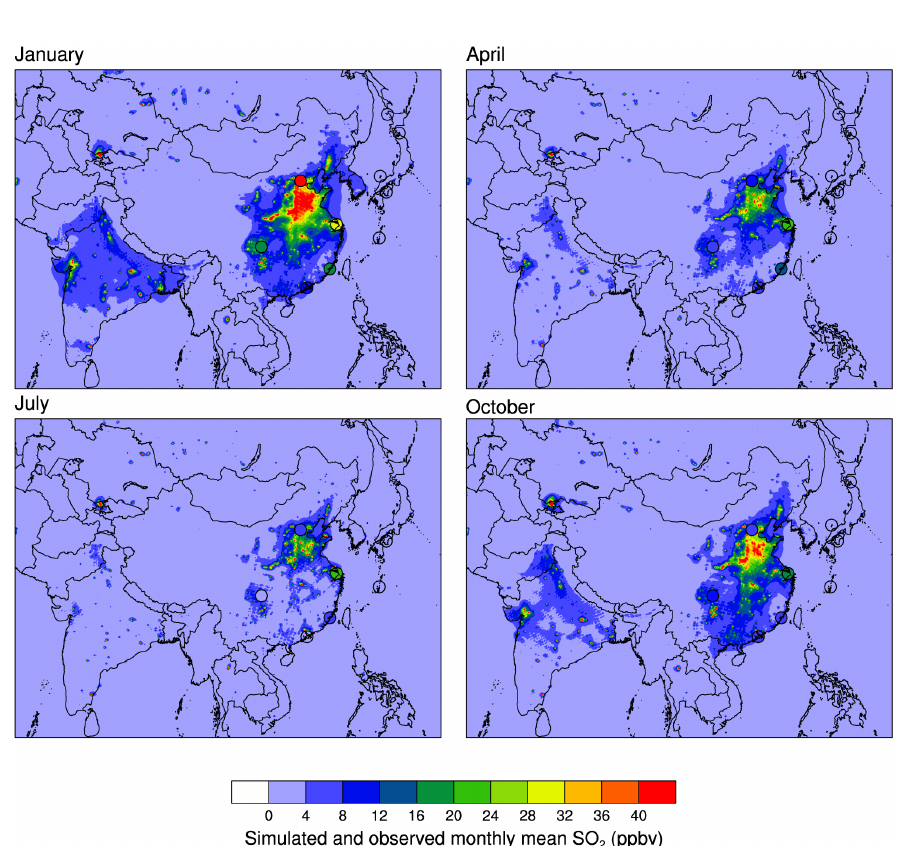
Figure 9. Simulated and observed monthly average surface SO 2 in 2007 using WRF-Chem–REAS. The filled circles indicate the observed monthly average